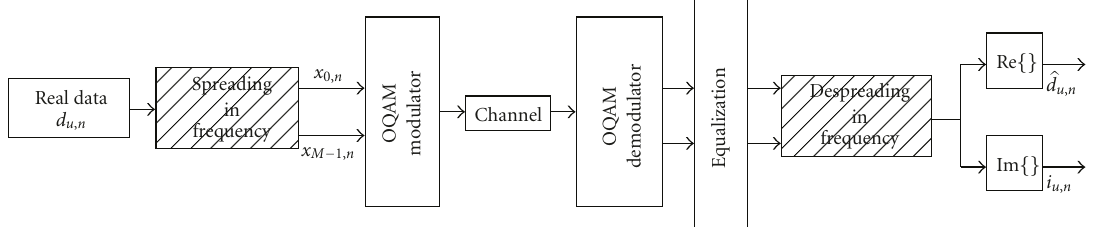
Figure 3: Transmission scheme for the CDMA-OFDM/OQAM system with spreading in frequency of real